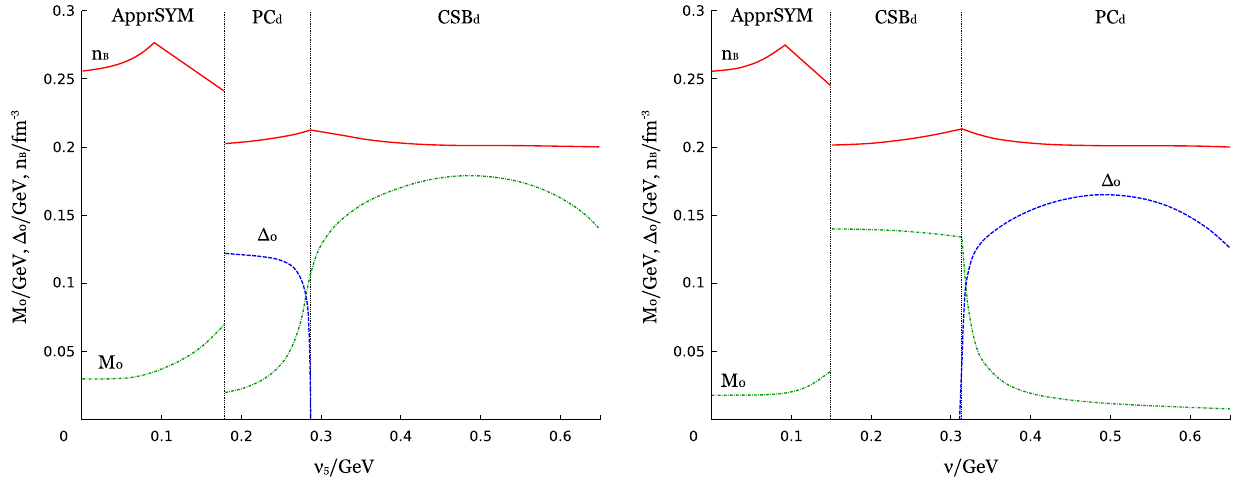
Fig. 4 The Gaps M 0 and (cid:13) 0 vs. ν 5 at μ = 260MeV and ν = 300 MeV (left panel). The same quantities M 0 and (cid:13) 0 vs ν at μ = 260MeV and ν = 300 MeV (right panel) 5